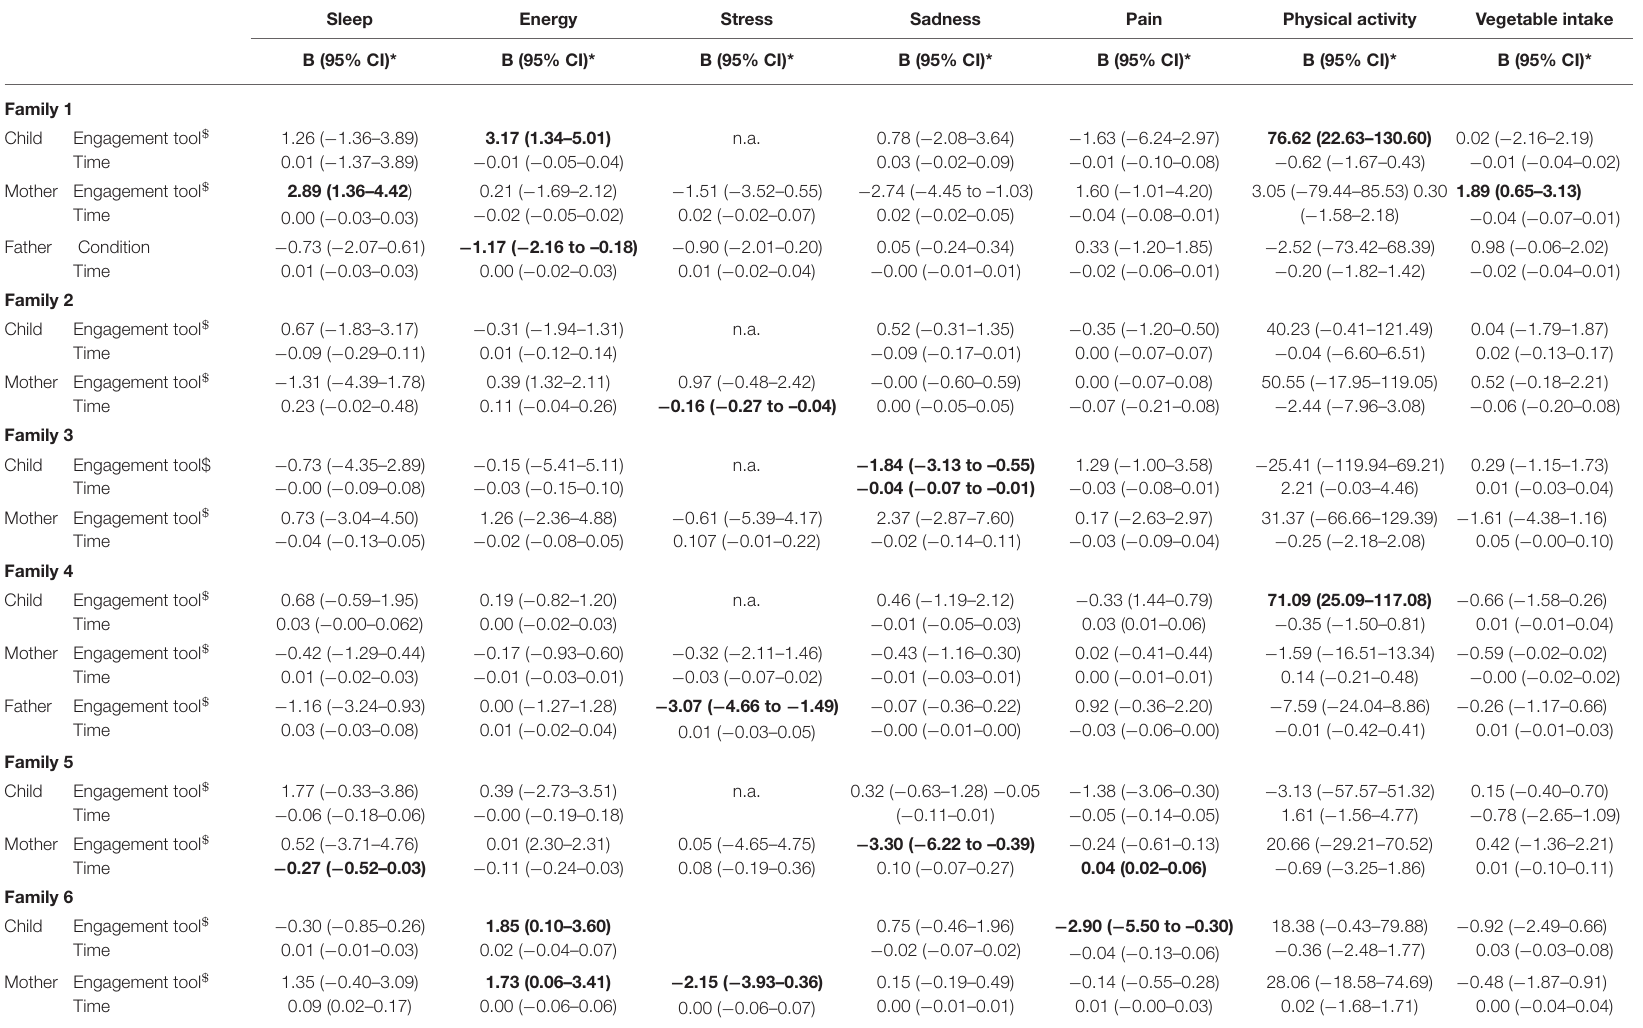
TABLE 3 | Regression analyses of the effect of time and pre and post first care professional visit for each of the eight families, separated for child, mother and father (when